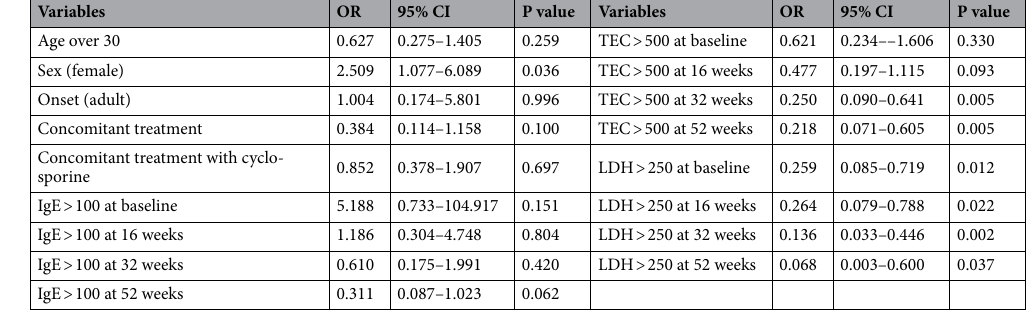
Table 5. The multivariate logistic regression analysis about each variable associated with achieving EASI 90 – female, TEC > 500 at 32 and 52 weeks, and LDH ≥ 250 at all time points showed significant difference, respectively. Each analysis was performed about the effect of each variable under adjustment to the baseline EASI, respectively.